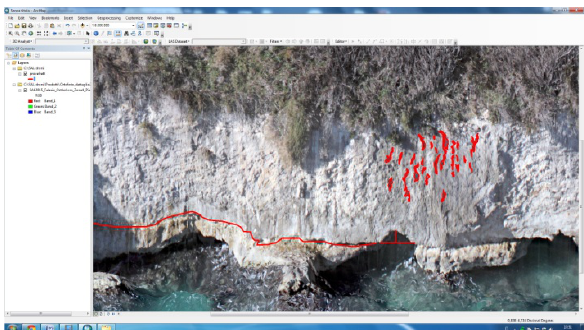
(red lines), surface unevenness (yellow line) and crumbling mass (green line).